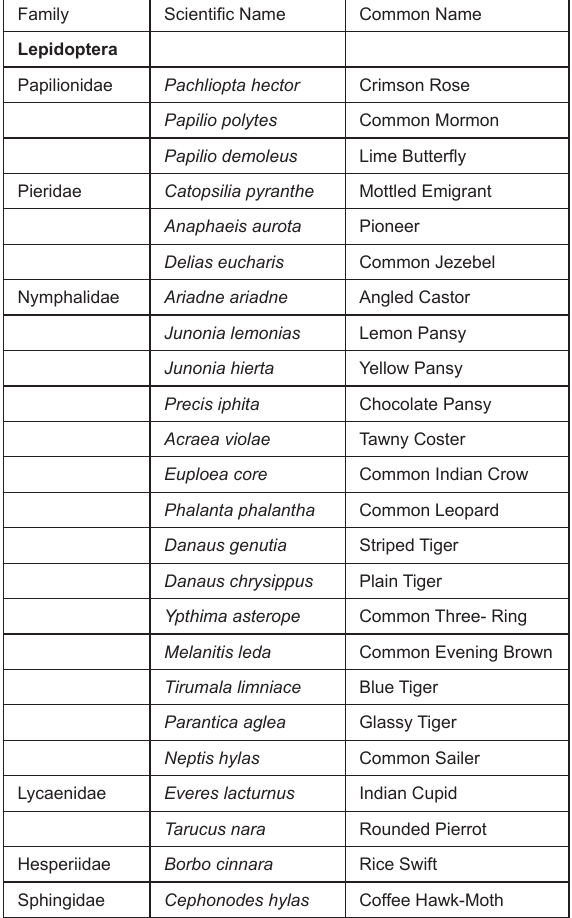
Table 1. List of butterflies on Chromolaena